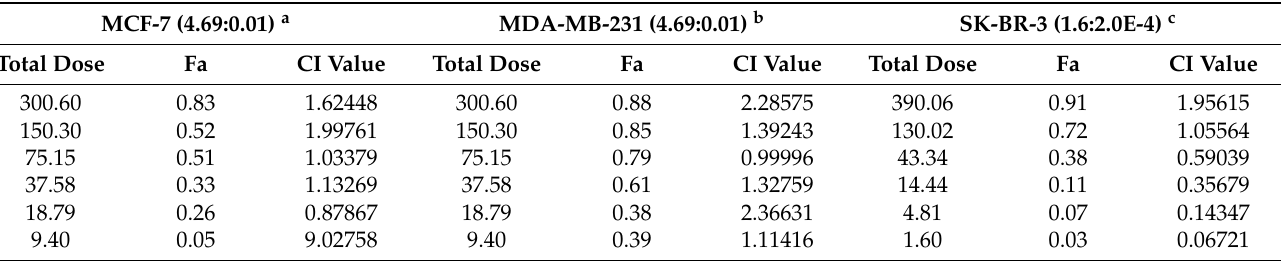
Table 9. Fa and CI values for actual experimental points of exemestane combined with idarubicin.